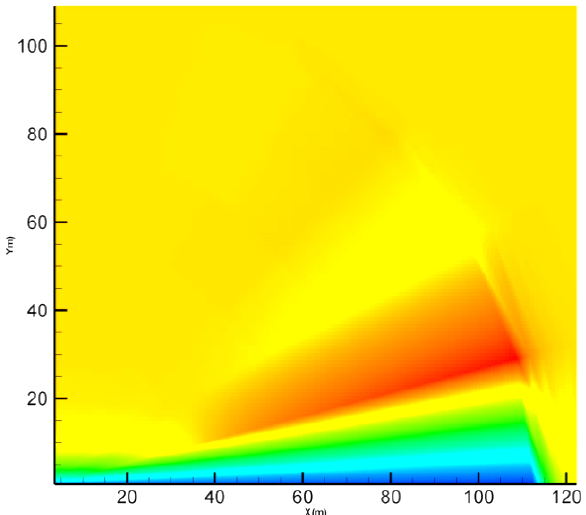
Figure 9. Gas pressure behavior at the early stage of the production process for Pi = 3100 psi, Pwf = 2550 psi, k-0.001 md and fracture length = 20 ft. The blue color is for P = 2550 psi and the red color is for P = 3100 psi.